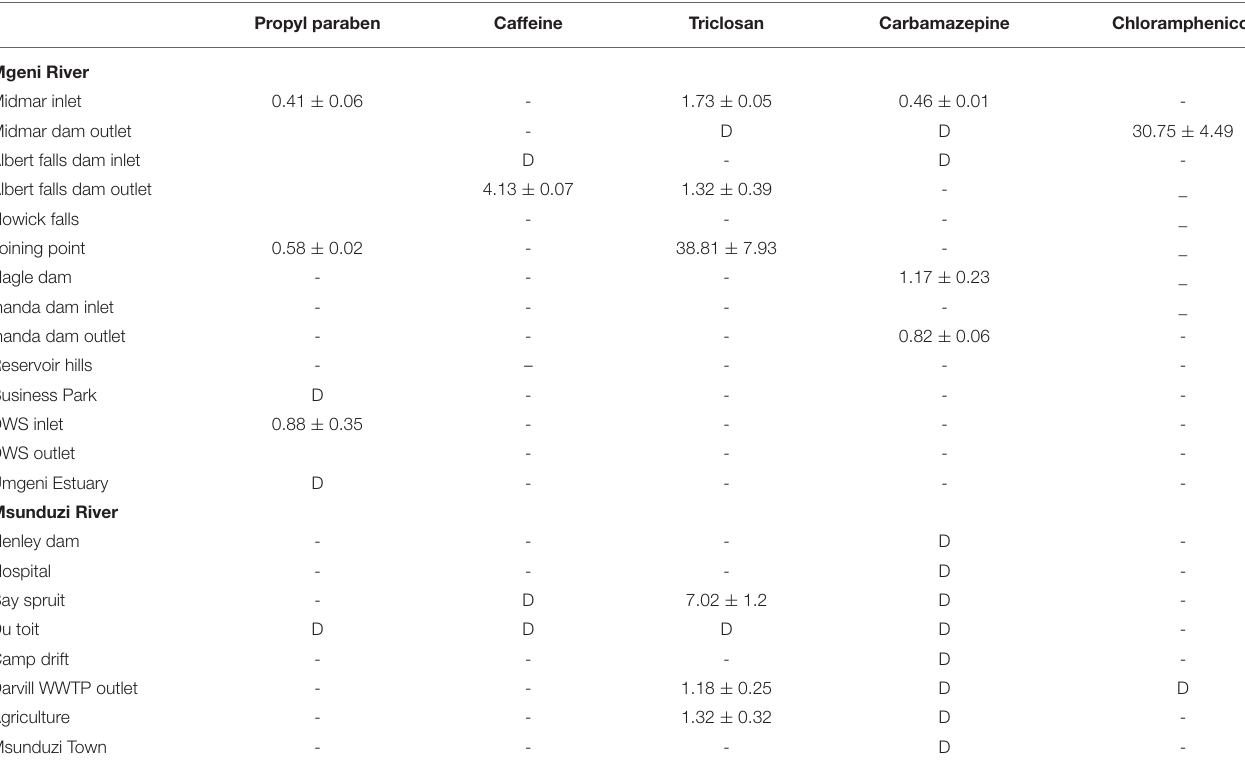
TABLE 2 | Concentration of the studied compounds (ng g − 1 ) in sediments collected in Mgeni and Msunduzi rivers in